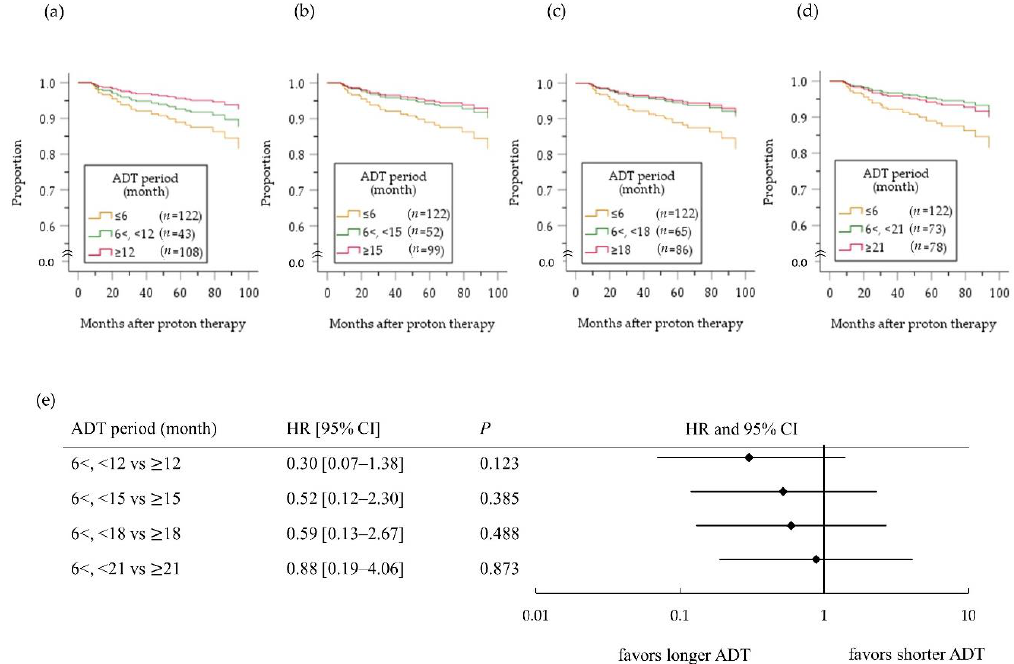
Figure 7. Cumulative survival function ( a – d ) and forest plots ( e ) assessing the risk of biochemical relapse in high-risk patients with a single high-risk factor who received ADT according to the ADT duration (months): < X vs. ≥ X months (a: X = 12; b: X = 15; c: X = 18; d: X = 21 months). ADT, androgen deprivation therapy; HR, hazard ratio; CI, confidence